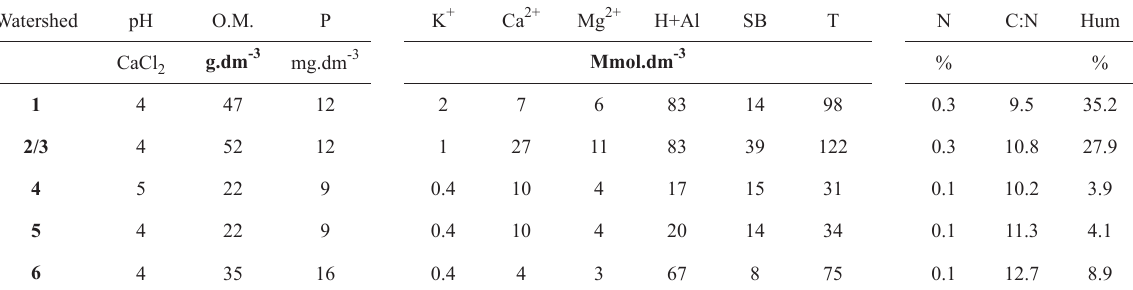
Soil characteristics of watersheds 1, 2, 3, 4, 5 and 6 (O.M.=organic matter; P=phosphorus; SB=sum of bases; Hum=